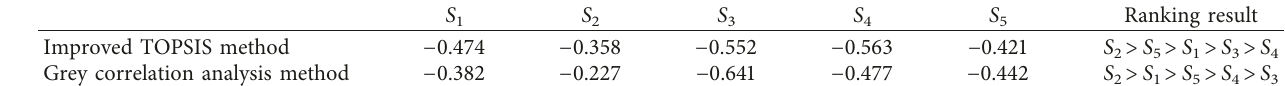
Table 6: The ranking results of alternative based on other decision-making